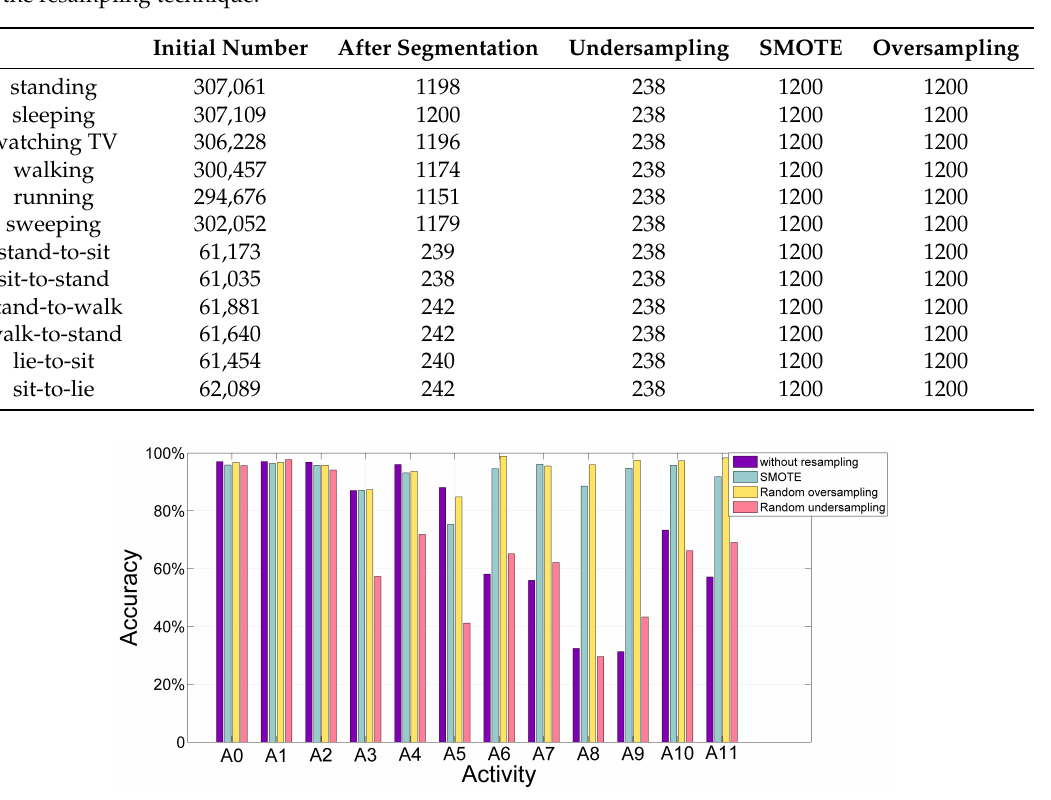
Figure 2. Accuracy of each activity class by applying random oversampling, SMOTE, and without resampling. (A0-standing, A1-sleeping, A2-watching TV, A3-walking, A4-running, A5-sweeping, A6-stand-to-sit, A7-sit-to-stand, A8-stand-to-walk, A9-walk-to-stand, A10-lie-to-sit, and